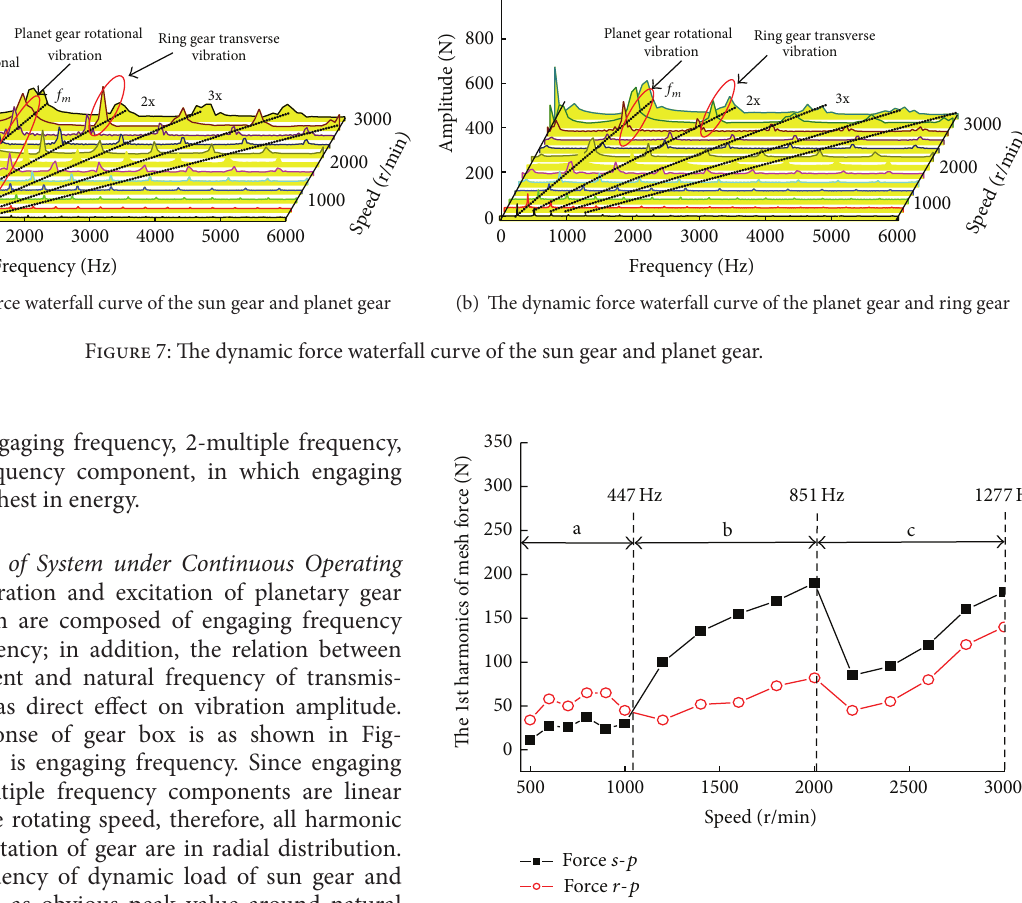
Figure 8: The dynamic force first-order harmonic component of ring gear and planet gear under different